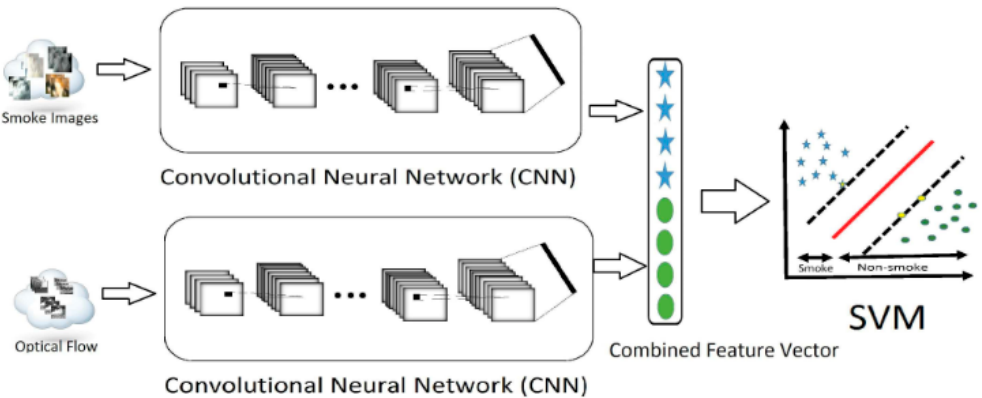
Figure 12. Bloc diagram of the Pundir method’s (smoke detection and classification) with two deep learning frameworks) [26].